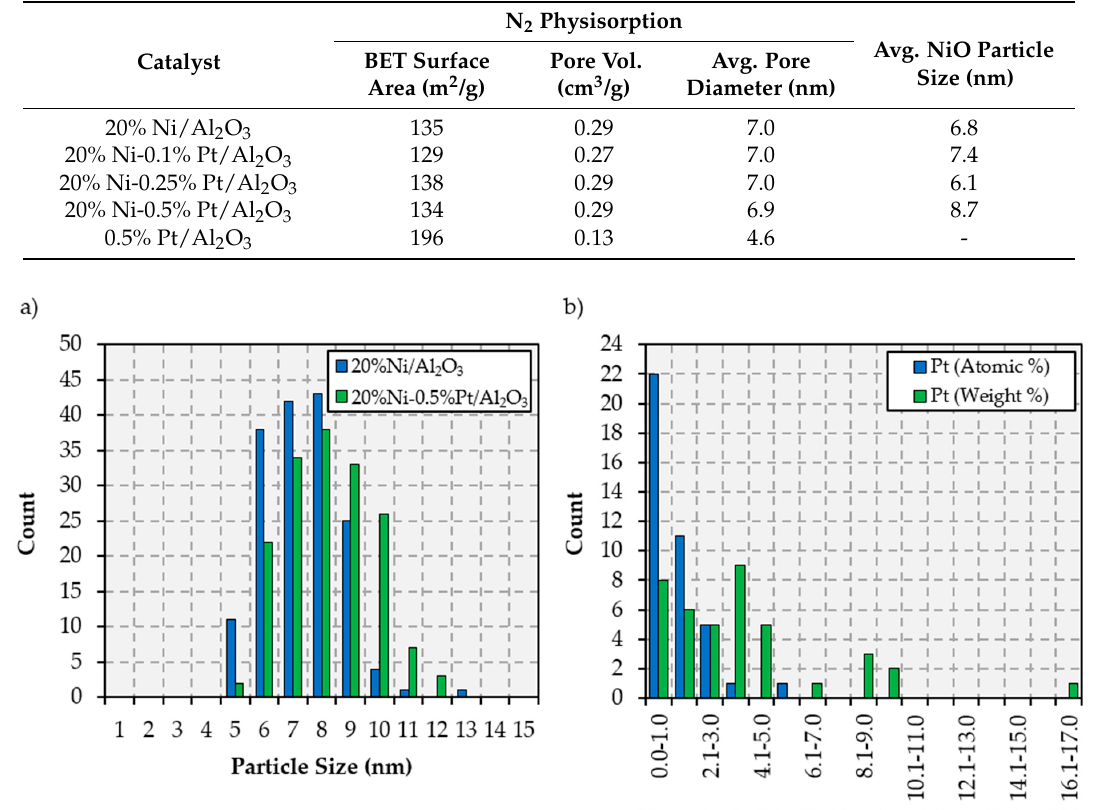
O and 20% Ni-0.5% Pt/Al O catalysts ( a ) and 2 3 2 3 O formulation ( b ). 2 3